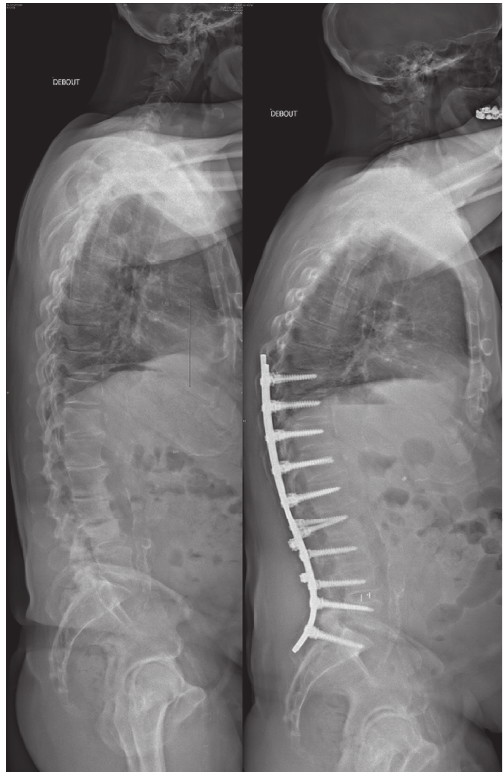
Figure 1: Clinical example of a patient from the “aligned group” with a low PI. Primary case, T9-S1 posterior fixation, multiples grade 2 osteotomies. Preoperative measurements (left) were PI � 41 ° , PT � 21 ° , PI-LL � 21, LL � -20 ° , TK � 22 ° , and SVA � 42mm. One-year